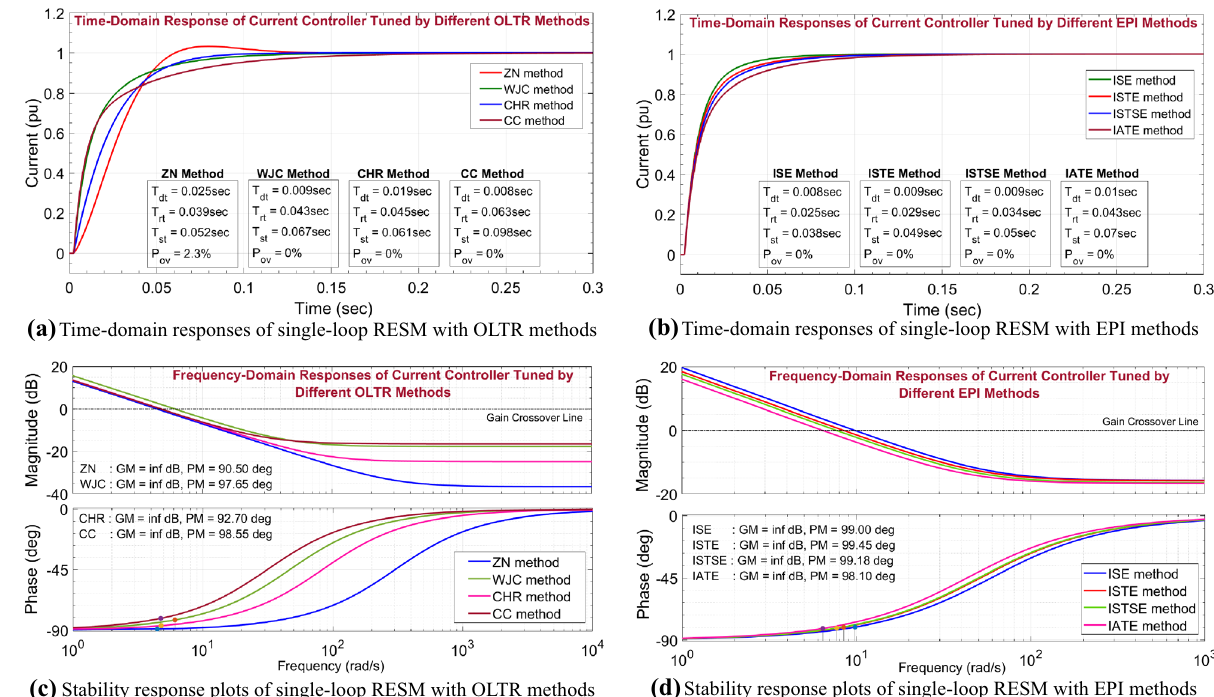
Fig. 11 Response of the single-control loop system (current controller based RESM) with conventional OLTR and EPI